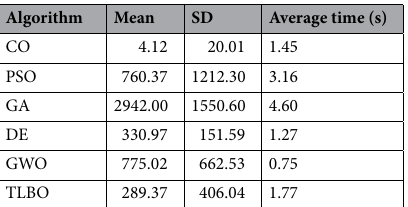
Table 1. Time comparison of some metaheuristic algorithms